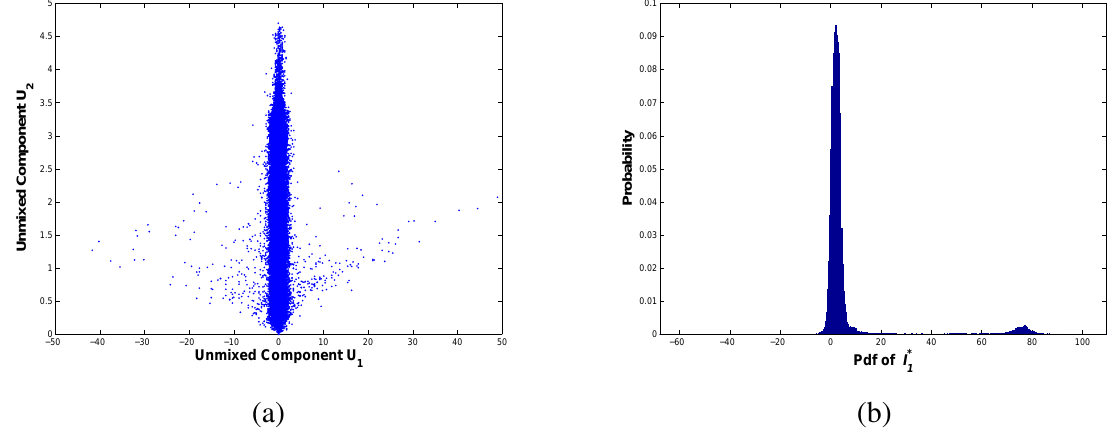
the pdfs of U and U ; the main component represents background information (vertical 1 2 component) and the second component represents foreground objects; In (b) the pdf of estimated I ∗ after removing background data. The global maxima correspond to background i data, and second maxima (right side) correspond to objects with